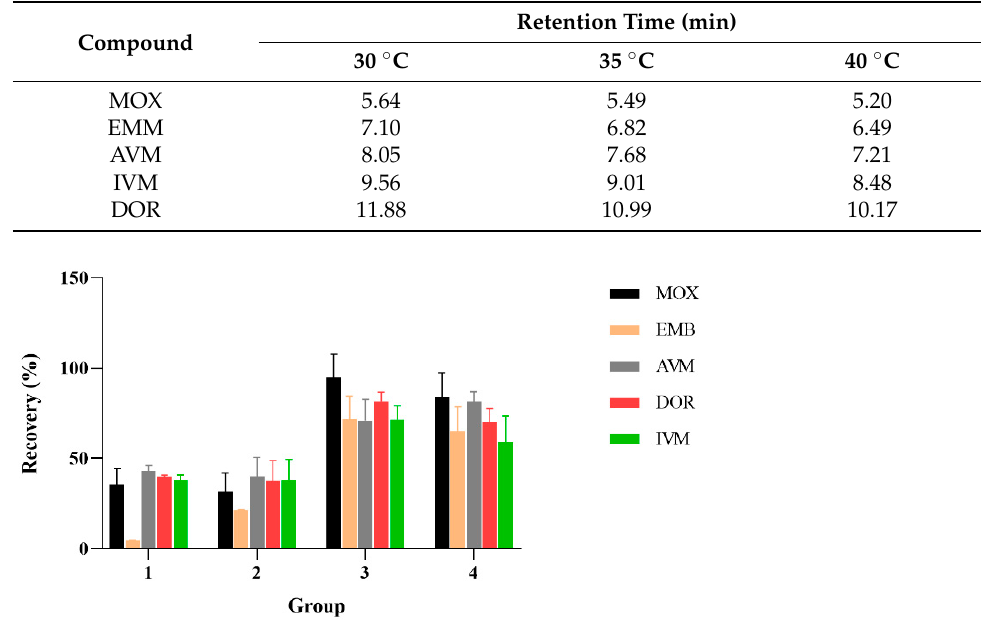
Figure 3. Effect of different extract reagents on the recoveries of the five AVMs (n = 6). 1: extraction